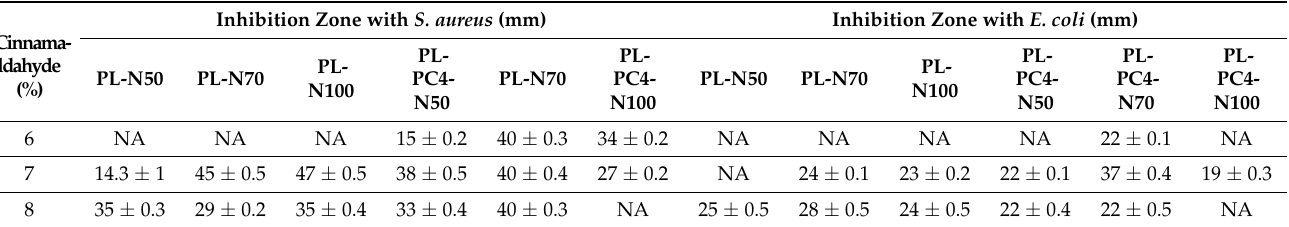
Table 8. Inhibition zones of porous PLA and PCL/PLA films for Staphylococcus aureus and Esherichia coli with different cinnamaldehyde